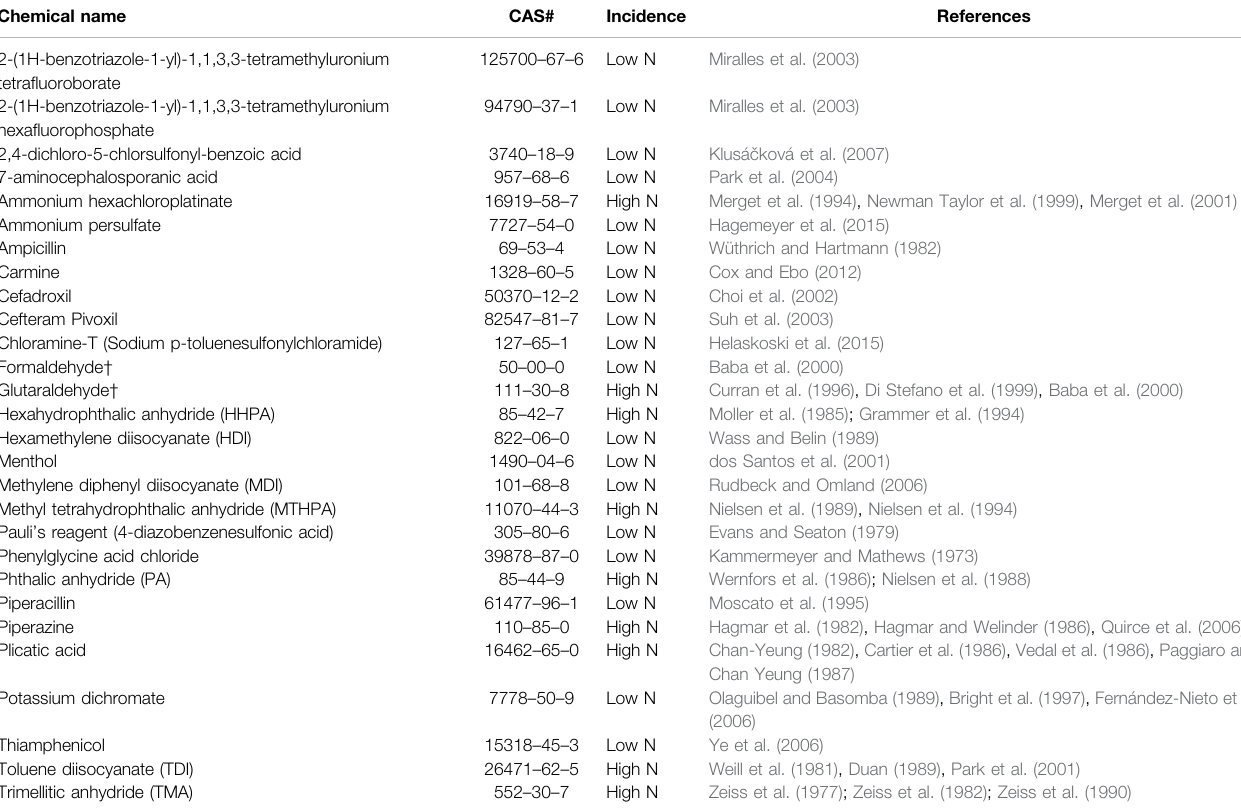
TABLE 1 | Identi fi ed Clinical Respiratory Sensitizers. A total of 28 clinical respiratory sensitizers were identi fi ed in our approach. Low N: 10 or fewer cases; High N: greater than 10 cases. † Two clinical skin sensitizers previously identi fi ed by human predictive patch tests (OECD, 2021) were identi fi ed as clinical respiratory sensitizers in our